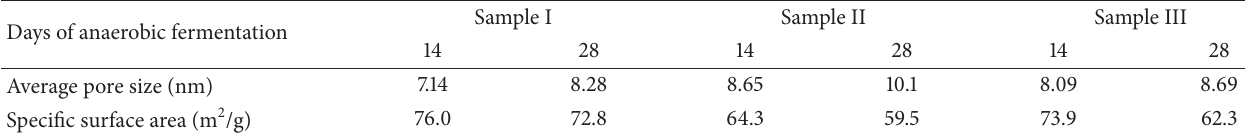
Table 2: The average pore size and specific surface area of